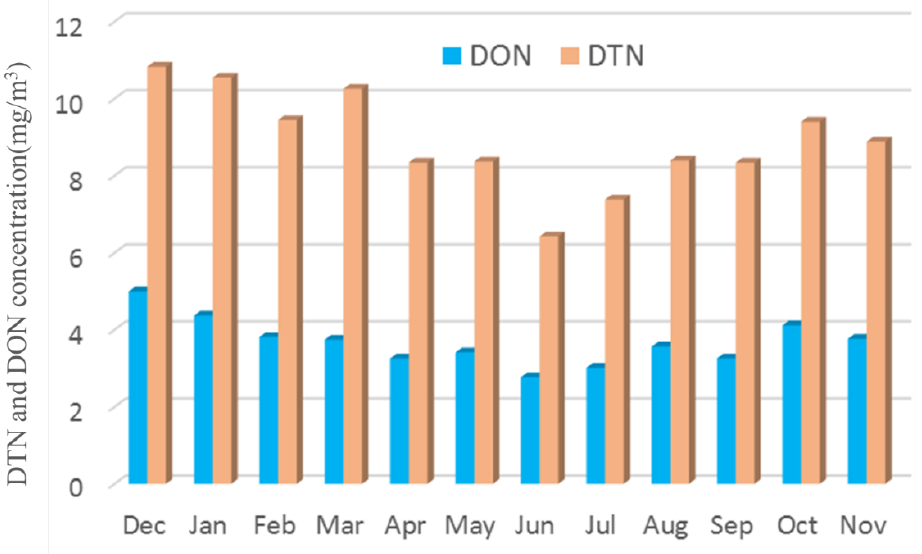
Figure 4. DTN and DON concentration (December 2020–November 2021).